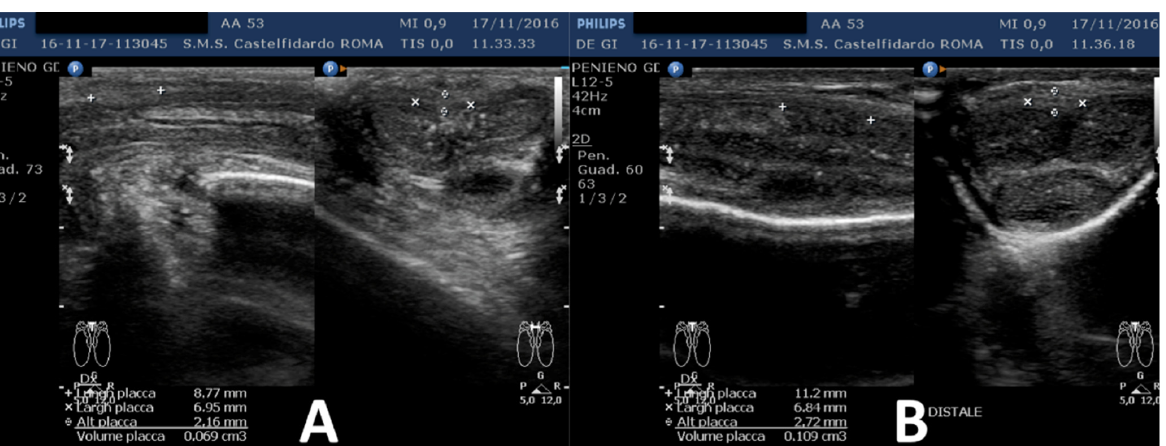
Figure 7. Ultrasonography of the penis after the first treatment cycle (longitudinal and transverse views). ( A ) First plaque. ( B ) Second plaque.